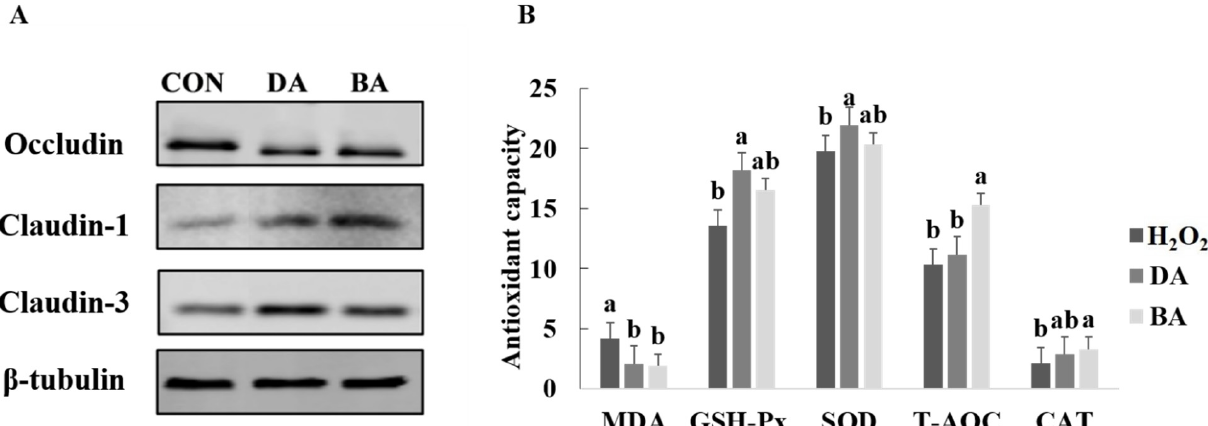
Figure 1. Effects of sodium decanoate and sodium butyrate on tight junction protein expression and antioxidant capacity in IPEC-J2 cells (Exp. 1). ( A ) Expression of tight junction proteins. ( B ) Antioxidase activity. A treatment concentration of 0.7 µ mol/L H 2 O 2 and a time treatment of 2 h were chosen to treat IPEC-J2 cells to develop a model of IPEC-J2 cells treated by H 2 O 2 . Concentration treatments of 1 mmol/L sodium decanoate and 0.5 mmol/L sodium butyrate were chosen to treat IPEC-J2 cells treated by H 2 O 2 . a,b Significant differences are indicated by different lowercase letters ( p < 0.05). CON: The control diet; BA: The basal diet supplemented with 0.5% sodium butyrate; DA: The basal diet supplemented with 0.5% sodium decanoate.